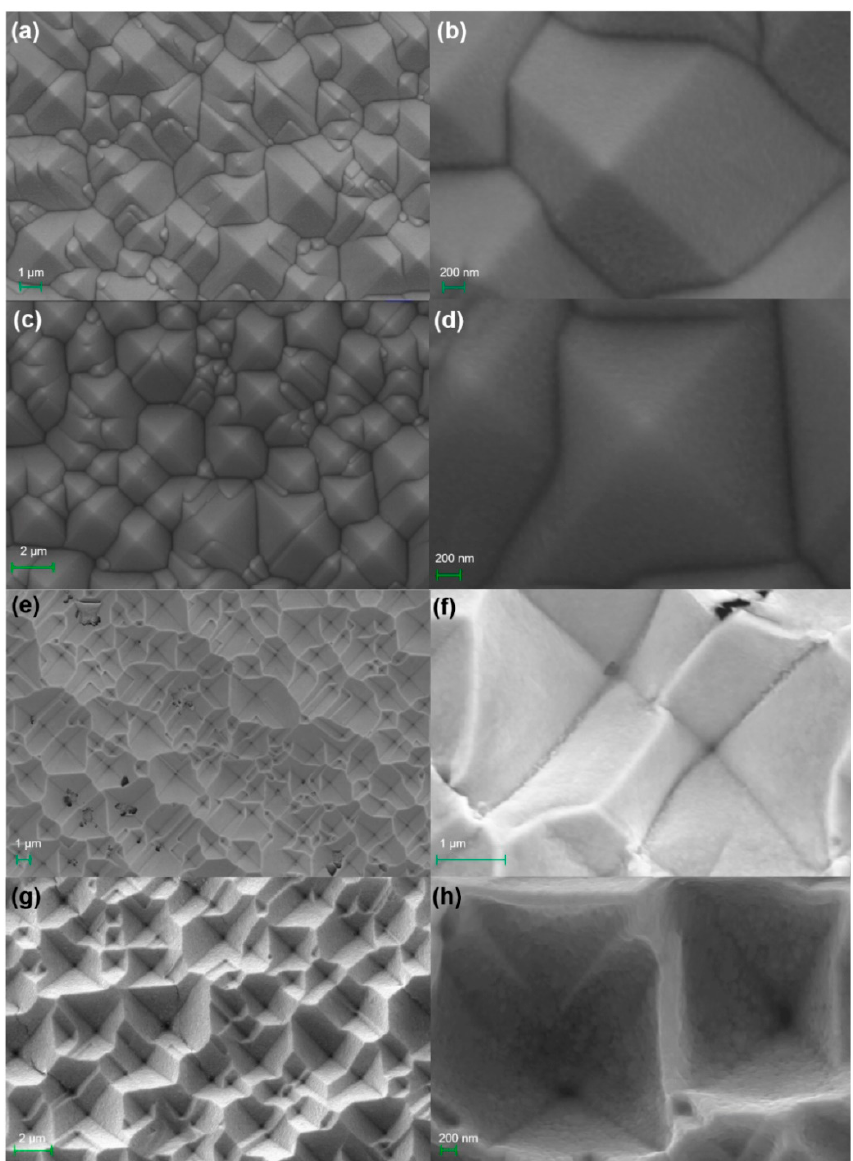
Figure 2. SEM images of four kinds of SERS substrate at different magnifications. ( a ) and ( b ) Au/PPS; ( c ) and ( d ) Ag/PPS; ( e ) and ( f ) Au/IPS; ( g ) and ( h ) Ag/IPS.